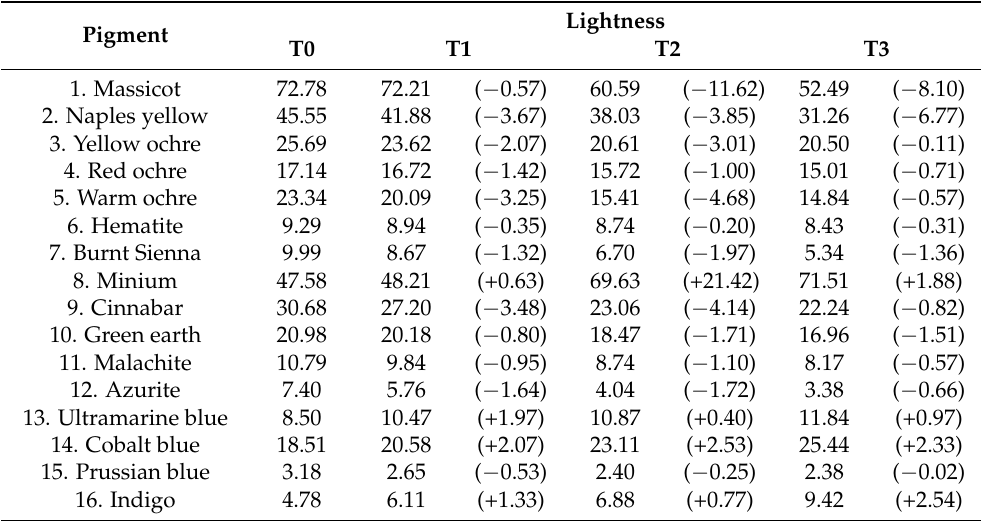
Table 2. Quantification of lightness at different aging steps for the fundamental pigments of Section 1.1. Values in parentheses denote the difference compared to the previous aging time-step.